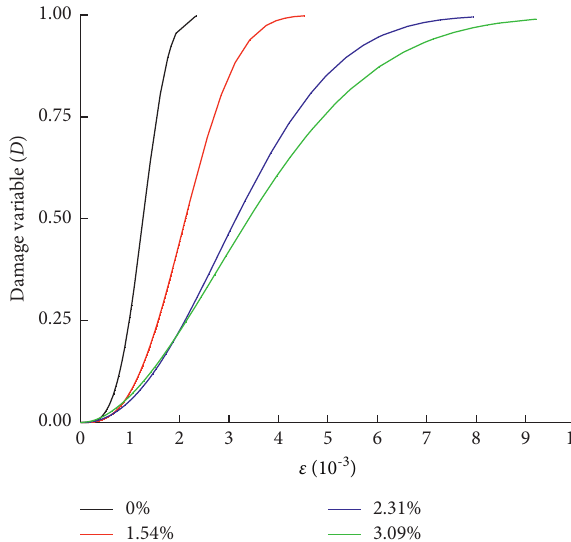
Figure 10: Damage evolution curves of uniaxial compression with different water contents.